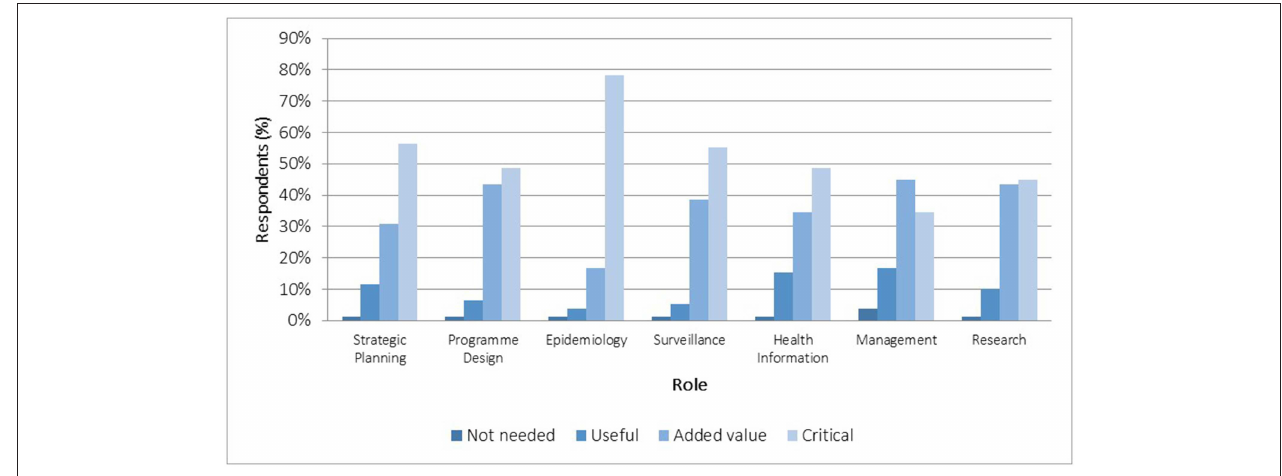
FIGURE 8 | Respondents’ perceptions of the importance of PHM specialists—by role ( n =